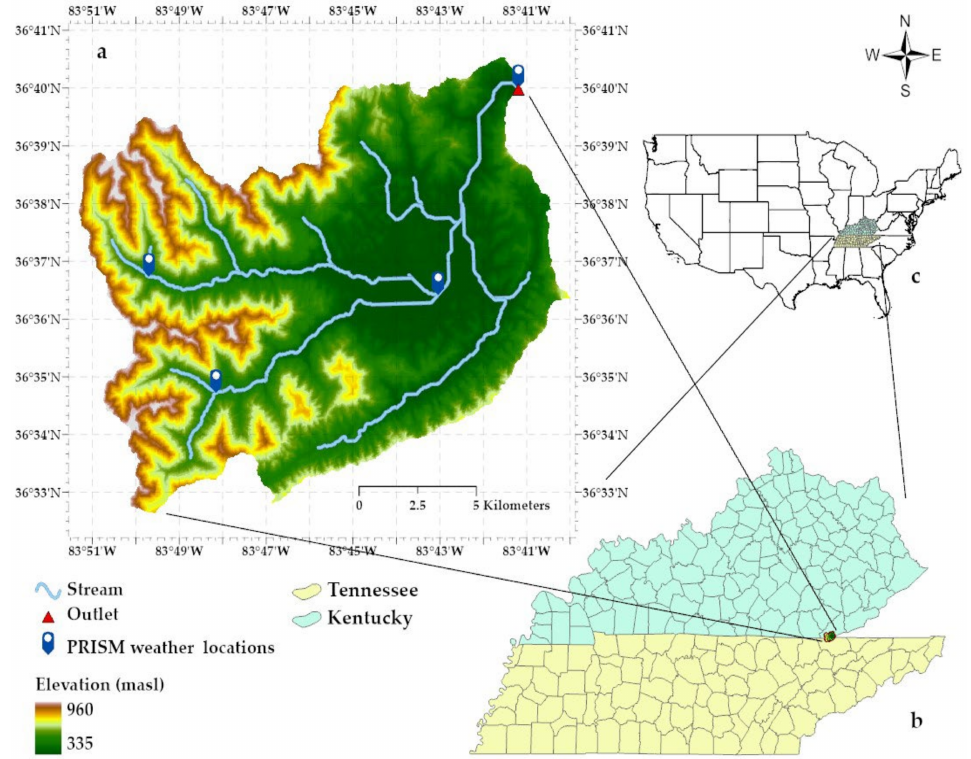
Figure 1. Location of the ( a ) Yellow Creek Watershed within ( b ) the states of Kentucky and Tennessee, and ( c ) the contiguous